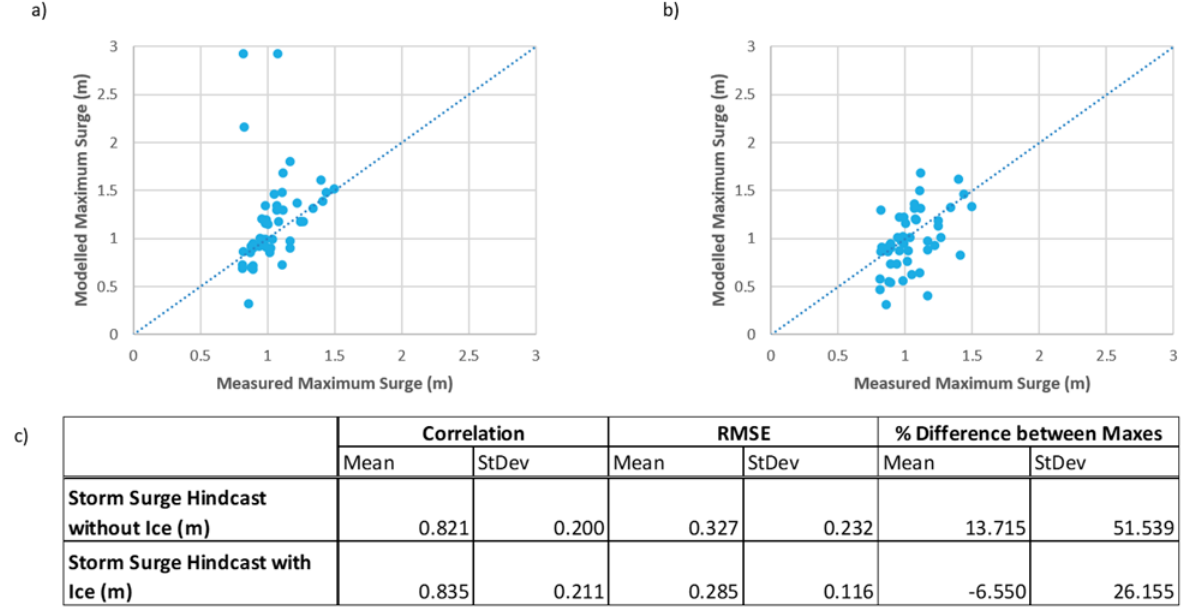
Figure 11. ( a ) Comparison of measured and modelled storm surge values without any corrections for ice. ( b ) Comparison of measured vs modelled storm surge values after correcting for the effects of ice as per Joyce et al. [22]. ( c ) Correlation, RMSE, and percent difference between the maximum values for each model.